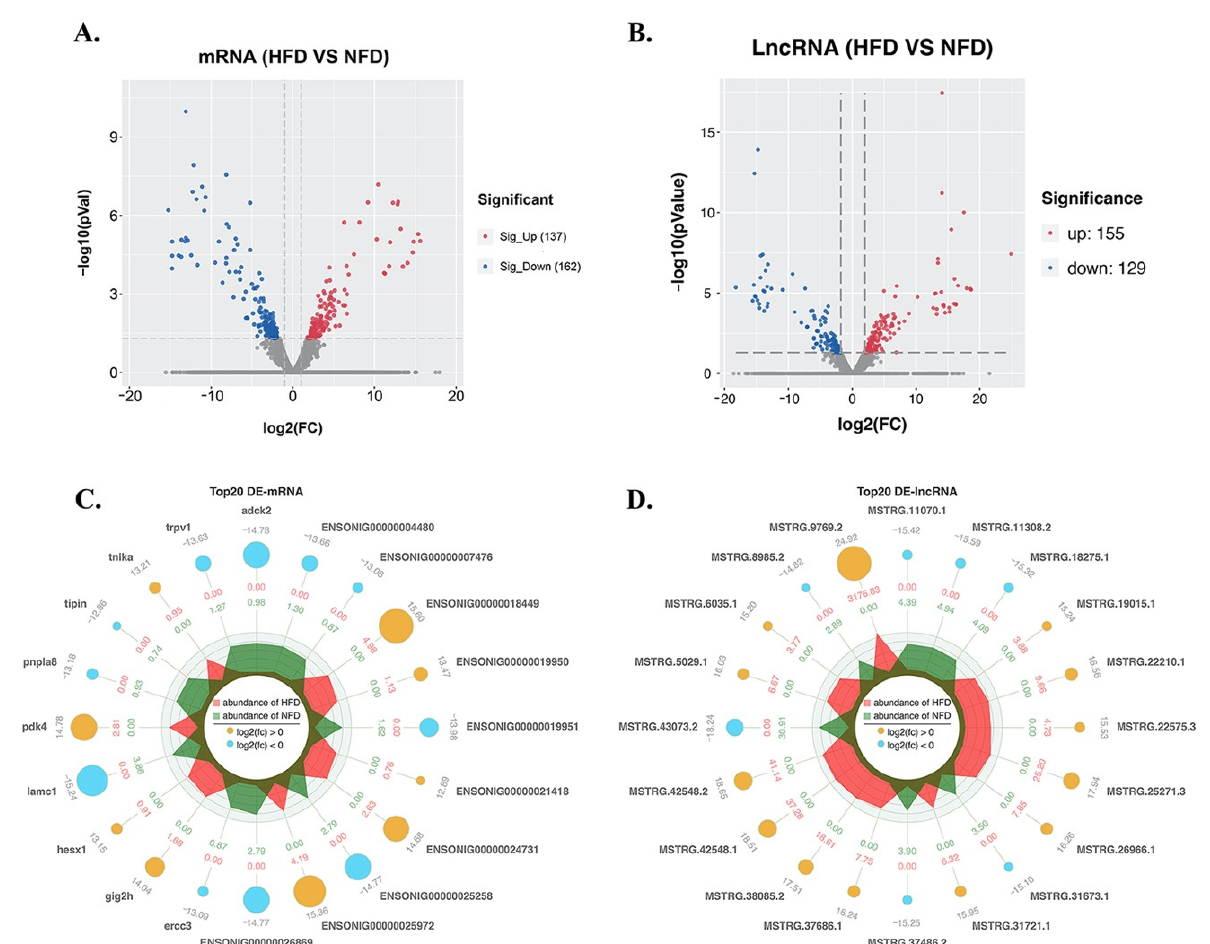
Figure 3. Differential expression analysis of lncRNAs and mRNAs. Volcano plot of differentially expressed (DE)-mRNAs ( A ) and -lncRNAs ( B ); Radar plots of the top 20 DE-mRNAs ( C ) and DE- lncRNAs ( D ).